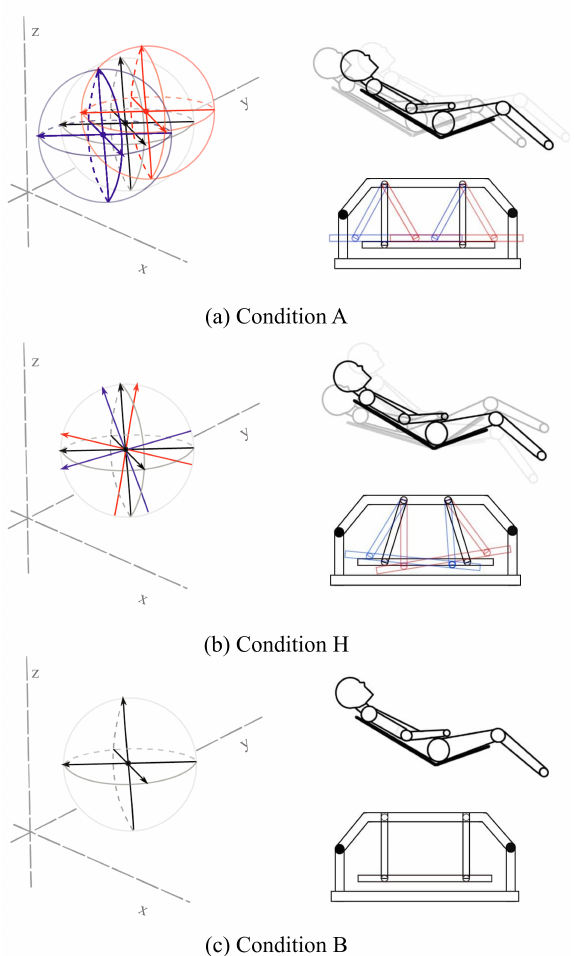
Figure 2. Rocking motion of the designed recliner chair. ( a ) Trajectory in the recliner Condition A. It has y -axis pitch movements; ( b ) Trajectory in the recliner Condition H. It has y -axis back-and-forth movements; ( c ) The control group is Condition B. It has no movement during the